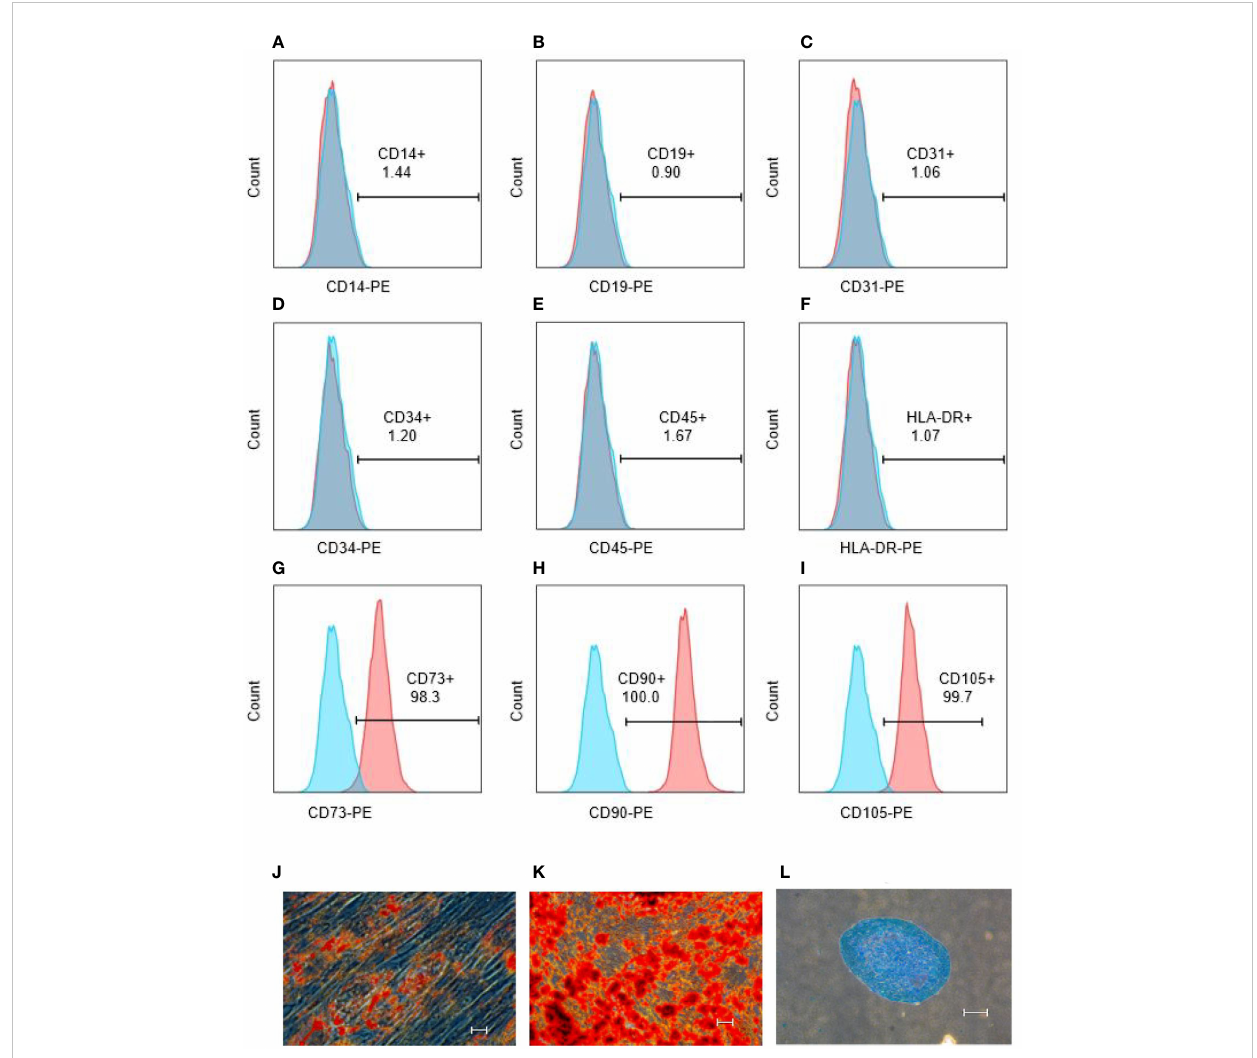
FIGURE 3 hUCMSCs surface markers detected by fl ow assay and three-lineage (adipogenic, osteogenic, chondrogenic) differentiation ability detected by immunocytochemistry before the injecting. (A – F) : the negative expression of surface markers CD14, CD19, CD31, CD34, CD45, HLA-DR of hUCMSCs; (G – I) : the positive expression of surface markers CD73, CD90, CD105 of hUCMSCs; (J) : Oil red O staining to analyze adipogenic differentiation of hUCMSCs; (K) : Alcian blue staining to explore chondrogenic differentiation of hUCMSCs; (L) : Alizarin red staining to analyze osteogenic differentiation of hUCMSCs. The scale bar = 50 m m in (J) and 200 m m in (K, L)